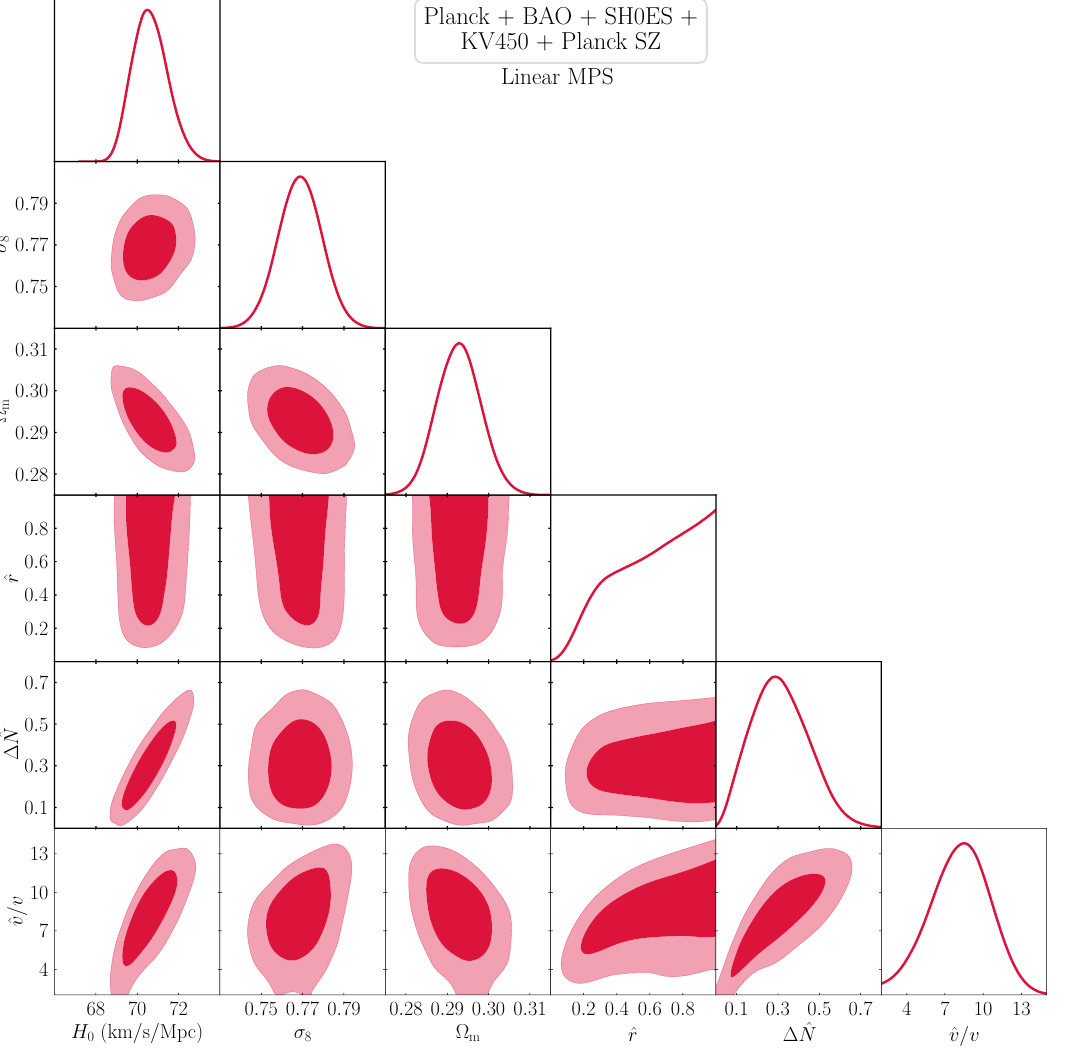
ˆ N obtained using